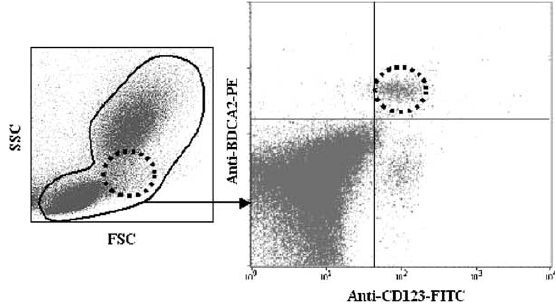
FIG. 1. Detection of DCs by flow cytometry. DCs have been gated from the whole PBMC population based on the SC versus FS distribution (black line). Then, in the gated cells the expression of particular antigens were assessed by triple-color flow cytometry. In the shown case, distinct BDCA-2 (cid:2) u CD123 (cid:2) u HLA-DR (cid:2) plasmacytoid DCs have been discriminated. According to size (FS) and cellular density (SC), the majority of pDC occurred between lymphocyte and monocyte populations (dashed circle).